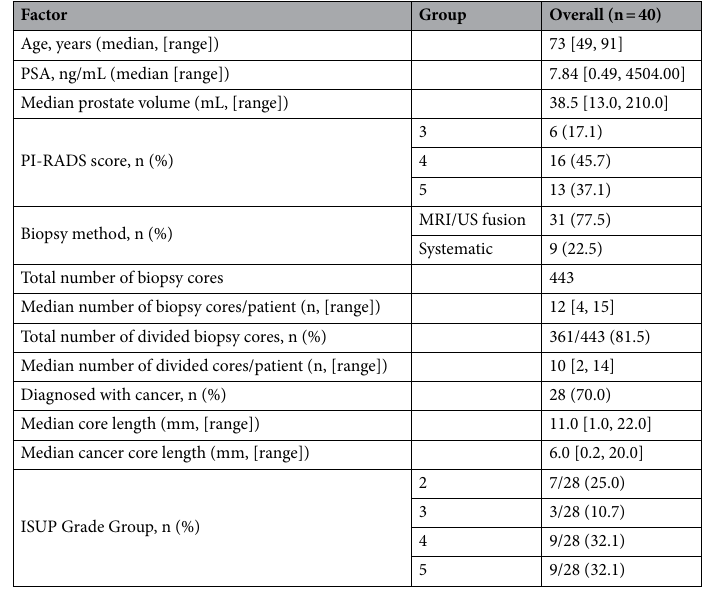
Table 1. Patients’ characteristics. PSA = prostate specific antigen; PI-RADS = prostate imaging-reporting and data system; MRI = magnetic resonance imaging; US = ultrasound; ISUP = International Society of Urological Pathology.